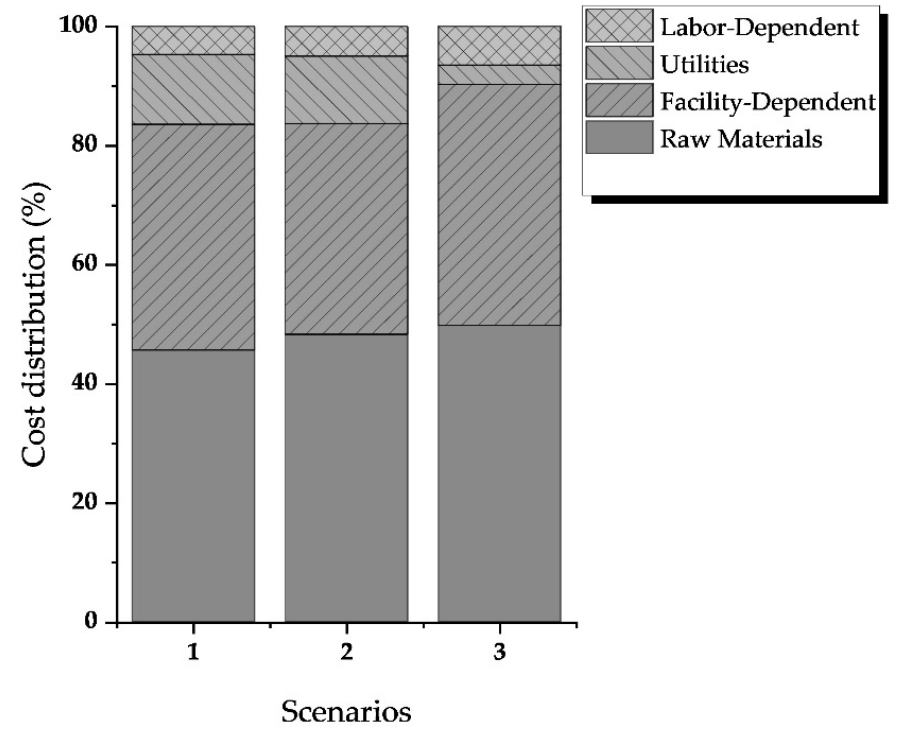
Figure 8. Distribution of the operating cost for scenarios 1, 2, and 3.